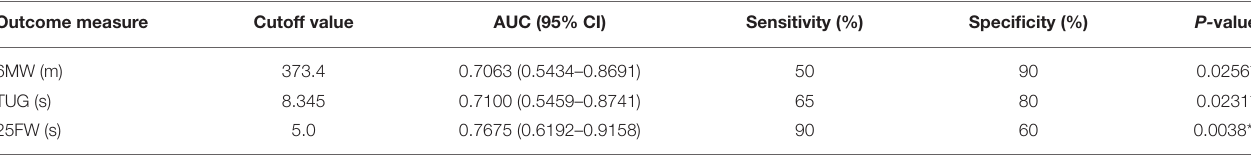
TABLE 5 | ROC analysis for predicting falls during SOT in patients with